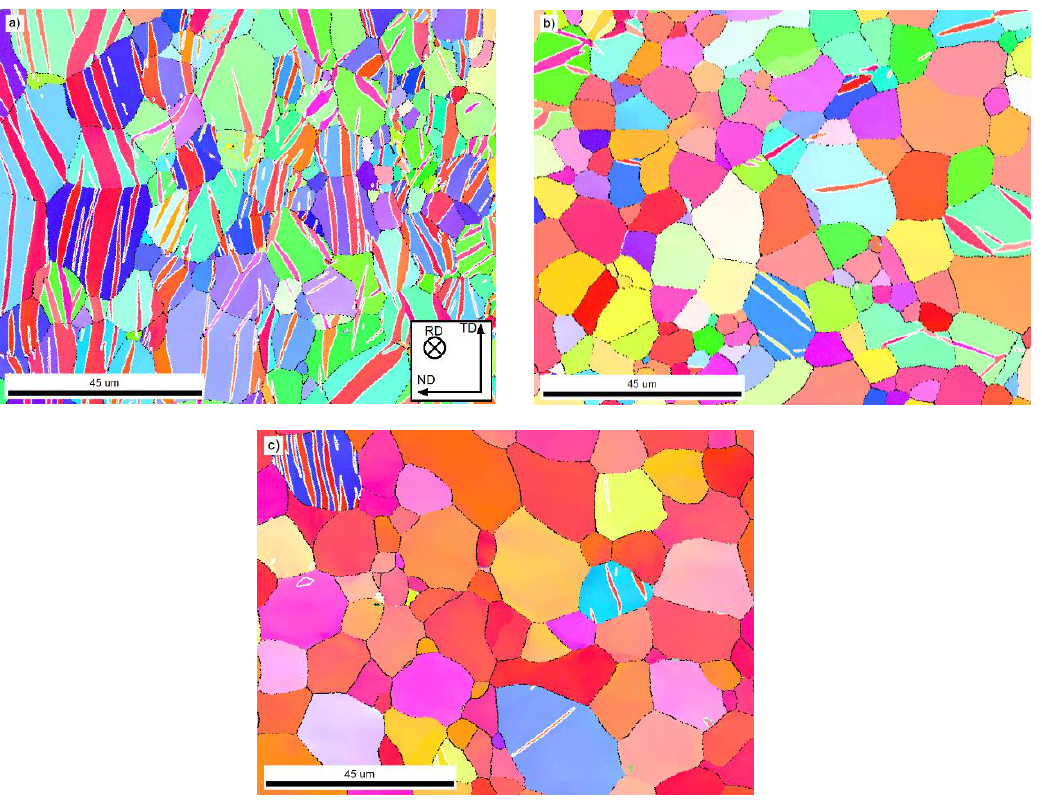
Figure 7. Microstructure of ( a ) RD, ( b ) 45, ( c ) ND samples deformed in compression to 1% plastic strain. Loading direction is perpendicular to the picture for all the sample.